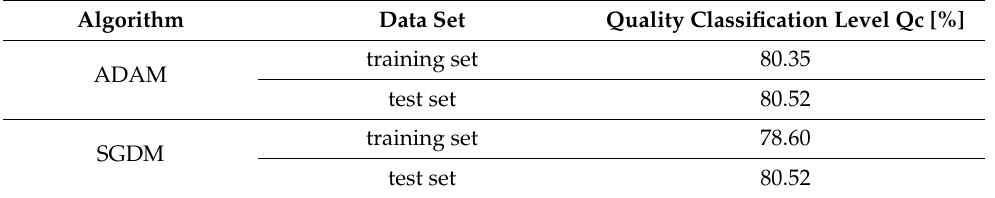
Table 2. CNN quality classification